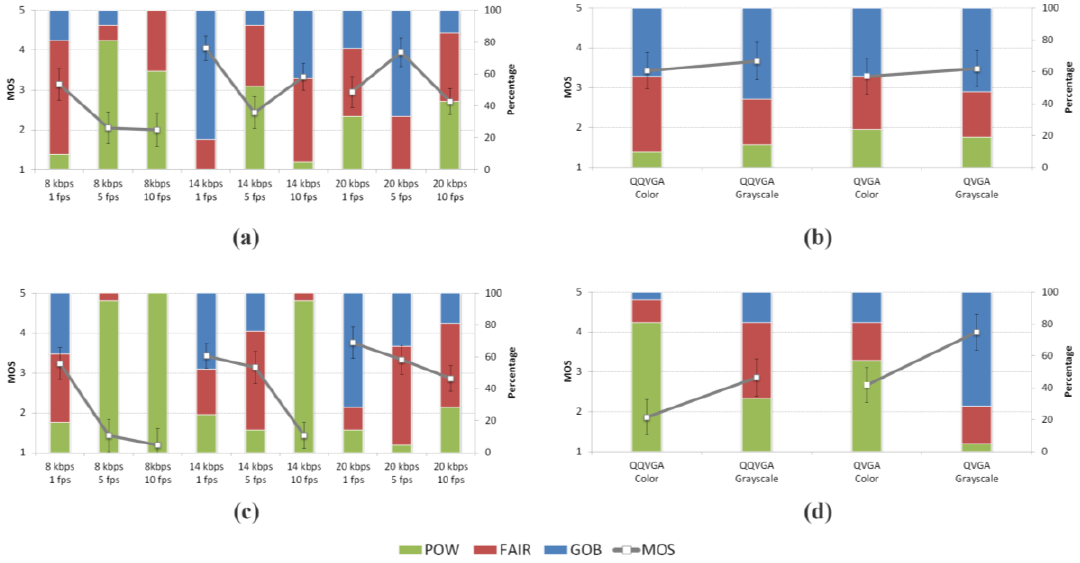
Figure 5. MOS values and cumulative distribution of scores as the percentage value of “good or better” (GOB-blue), fair (FAIR-red) and “poor or worse” (POW-green) scores. ( a ) Block 2; ( b ) Block 3; ( c ) Block 4; ( d ) Block 5.